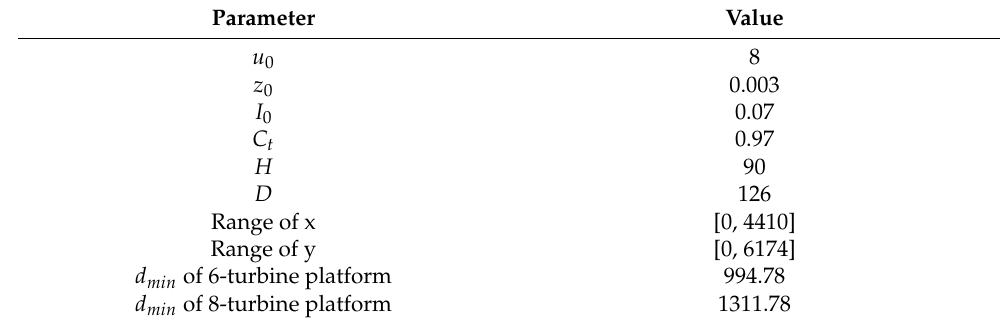
Table 3. Parameters for optimization.